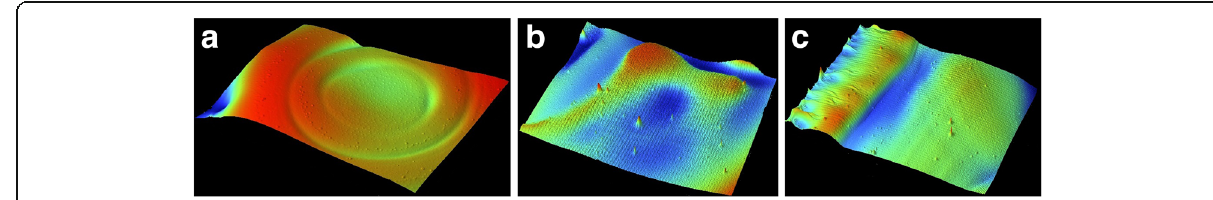
Fig. 9 3D surface morphologies of the silver films heat-treated at ( a ) 25 °C, ( b ) 100 °C, and ( c ) 140